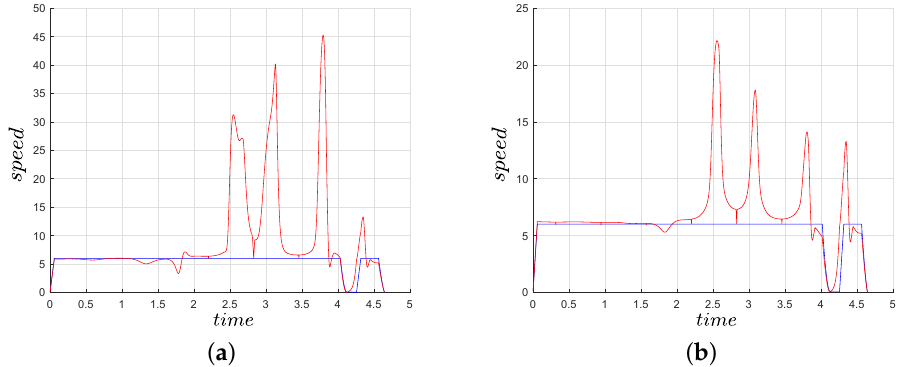
Figure 10. In blue, the norm of the desired velocity. In red, the norm of the modulated velocity. The plot ( a ) shows the velocity of the modulation without a waypoint for the sphere, while ( b ) shows the modulated velocity using a waypoint for the